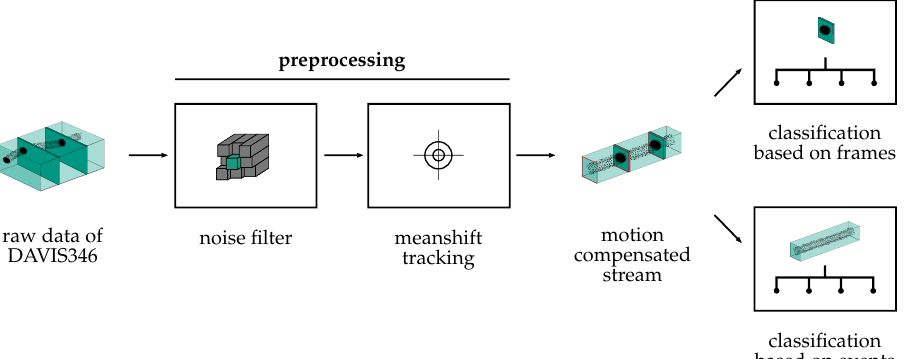
Figure 2. Overview on the modular pipeline used to classify objects based on intensity images and events. The DAVIS346 camera records conventional frames at a constant frame rate and an asynchronous event stream of the moving object in the camera’s FoV. The event stream is denoised by a spatio-temporal filter and a meanshift tracking algorithm determines the object’s centroid based on events only. All information about frames and events is compressed to an ROI formed around the object’s center which leads to a compensation of lateral motion. Based on this, different classification methods are applied and